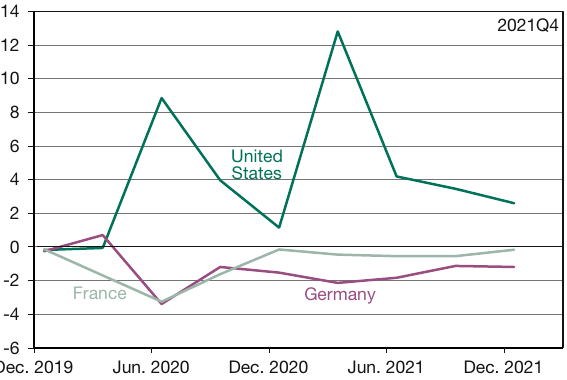
Figure 8 HICP infl